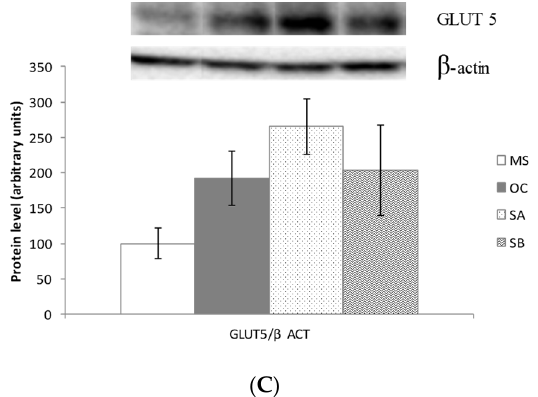
Figure 6. Effects on glucose uptake of MetS rats (MS, n = 10), rats fed with wheat control diet (WC, n = 10), wheat and oat control diet (OC, n = 10), A snack (SA, n = 10), and B snack (SB, n = 10). ( A ) Glucose uptake involved genes mRNA levels, ( B ) GLUT2 protein levels and ( C ) GLUT5 protein levels. Values are expressed as mean ± SEM. Values not sharing a common letter are significantly different ( p < 0.05).